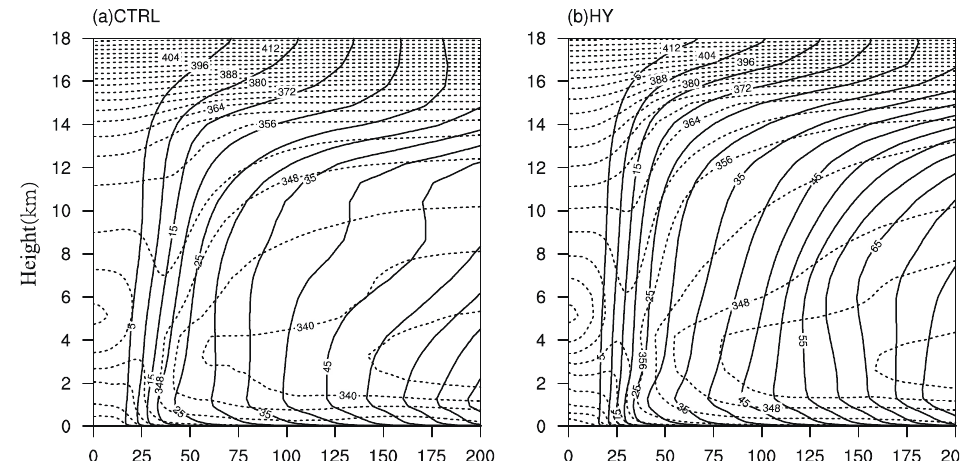
Figure 9. Height–radius cross-sections of the azimuthal-mean equivalent potential temperature θ e (dash line; every 4 K) and absolute angular momentum (AAM) (solid line; 5 × 10 5 m s − 2 ) for ( a ) CTRL and ( b ) HY.